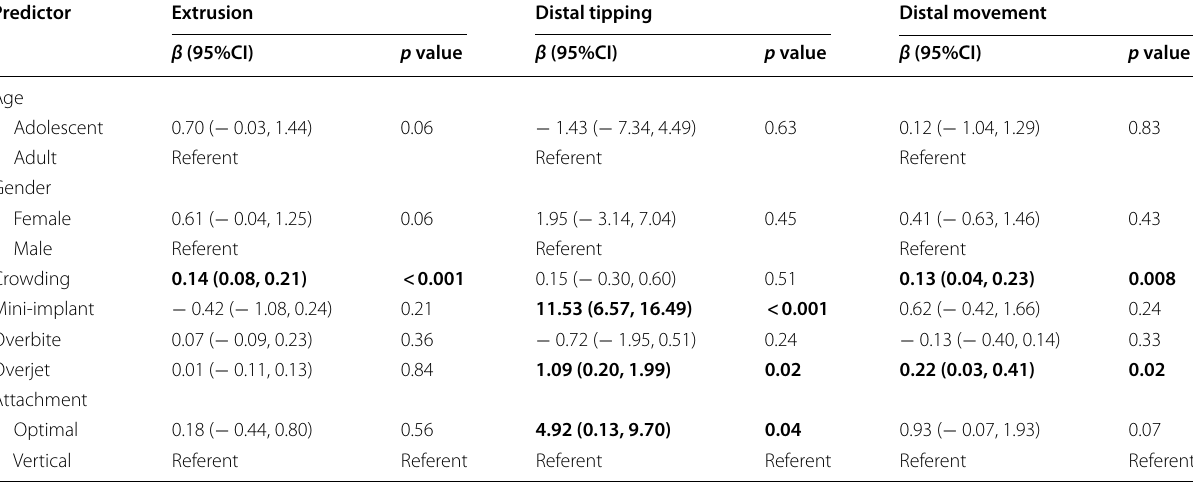
Bold values indicate statistical significance ( p < 0.05)